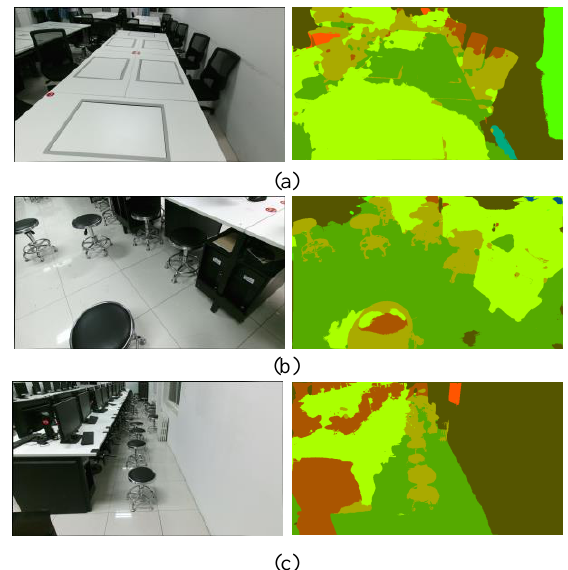
Figure 4. Unsatisfactory semantic segmentation results for tables, seats by RGBD+MMD2+CRF. (a)